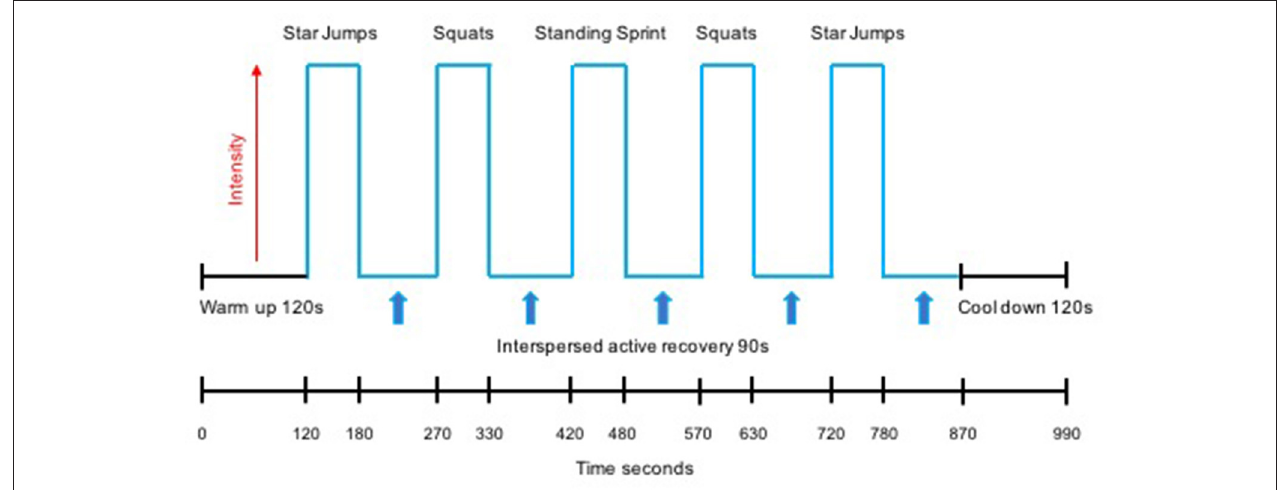
FIGURE 1 | Schematic representation of the high intensity interval training (HIIT) protocol.